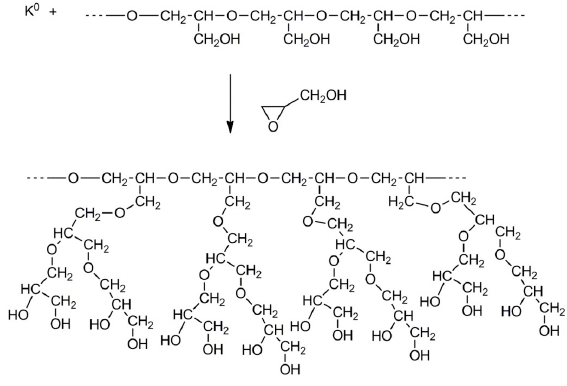
Scheme 16. Linear polyglycidol with hyperbranched grafts.